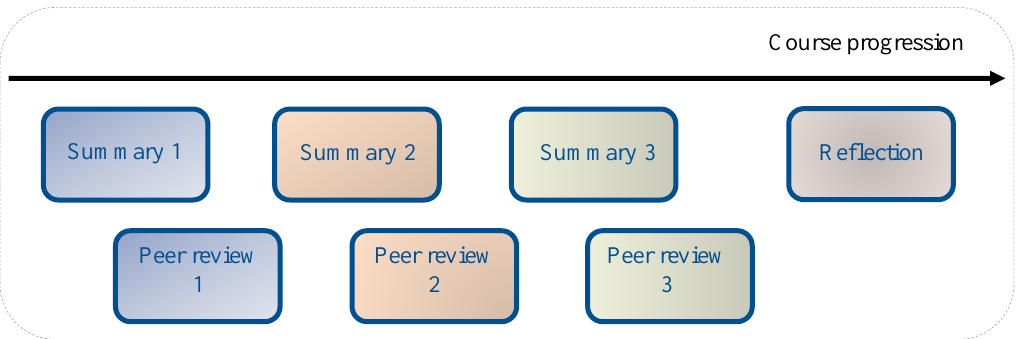
Figure 6. The seven components of the